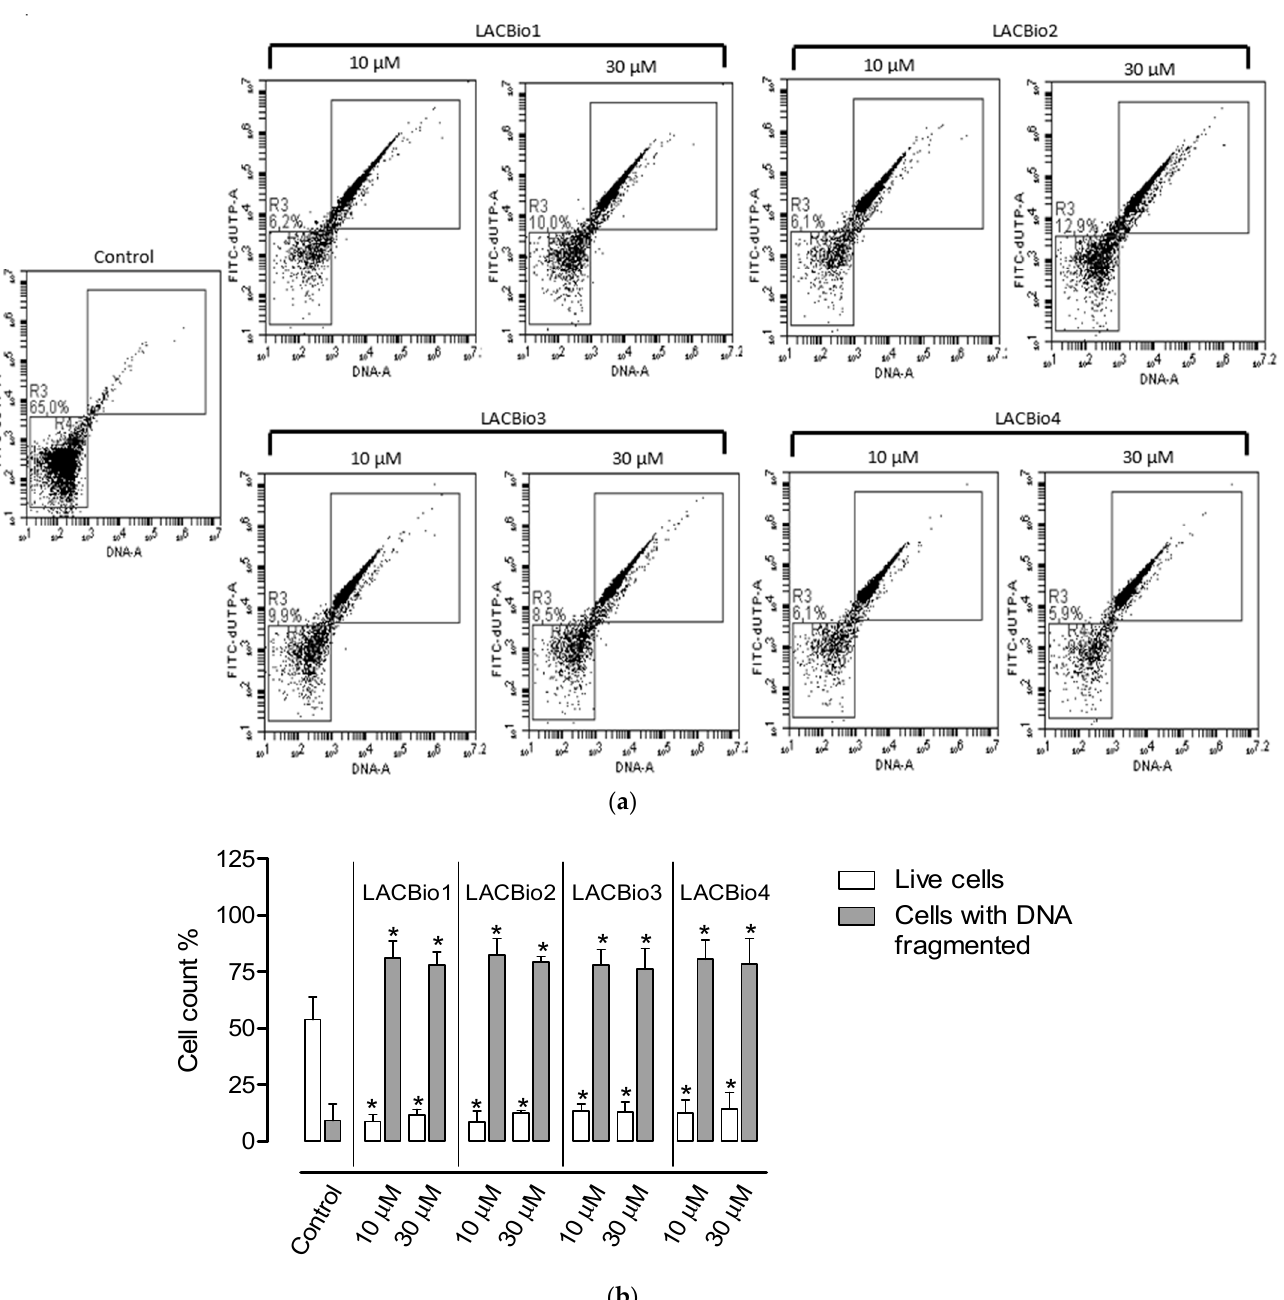
Figure 2. LACBio1, LACBio2, LACBio3 and LACBio4 caused DNA fragmentation in MDA-MB 231 cells. Cells were treated with compounds for 24 h. Representative data obtained by cytometric analysis are shown in ( a ), and cell counts are shown in ( b ) (in %). All the values are presented as the mean ± standard error of three independent experiments. Statistical analyses were performed in GraphPad Prism 8.02 and included one-way ANOVA with Dunnett’s post hoc test, and statistical significance was defined as * p < 0.05. Table 1. Effects of LACBio1, LACBio2, LACBio3 and LACBio4 on MDA-MB 231 cell cycle phases. Samples of cells were stained with propidium iodide, and the cellular DNA content was determined by flow cytometry.